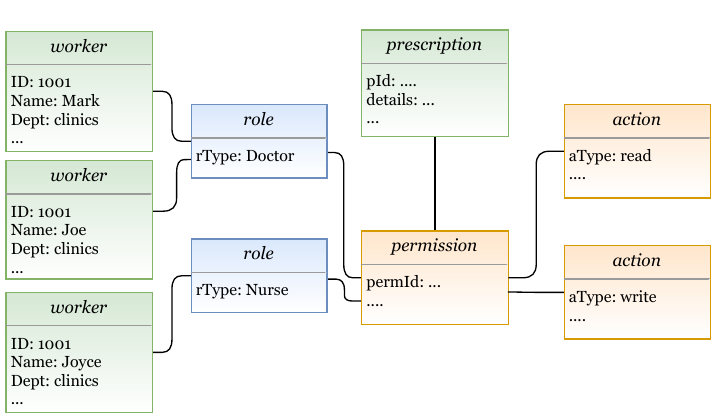
Figure 22. A model instance based on RBAC. The generated RBAC policy in Figure 23 is modeled based on RBAC model, explained in Section 5.1.3. As shown in the Figure, the model includes several elements, and the three rules are generated based on them.